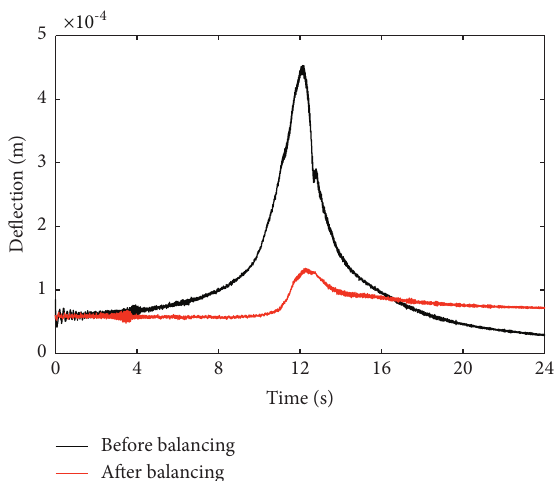
Figure 18: The transient deflection of the measuring point before and after balancing by the ICM